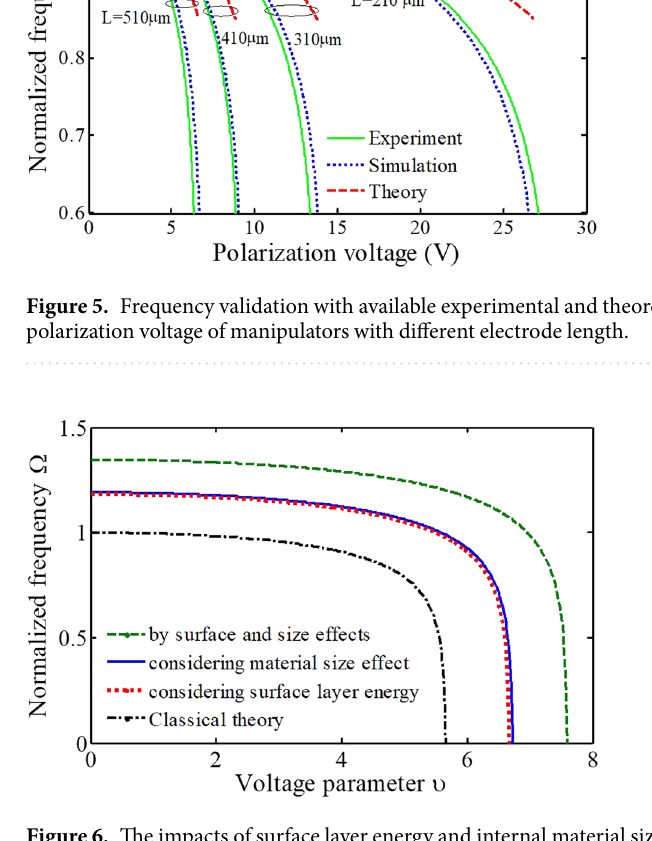
Figure 6. The impacts of surface layer energy and internal material size of the deformable electrode on the sensor behavior (T = 273